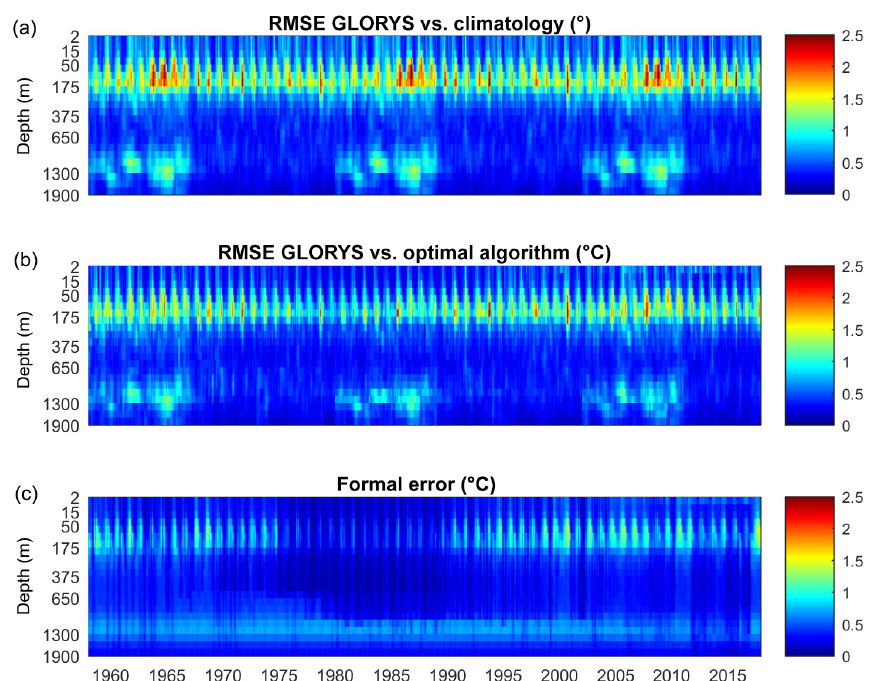
√ ˜ σ 2 ) of the background errors (in ◦ C). (b) Root-mean-square error (RMSE, in ◦ C) of the analysis fields Figure 7. (a) Standard deviation ( (cid:112) ˆ U 2 , in ◦ C). Note the vertical axis is distorted to enhance the visualization obtained using synthetic data from GLORYS. (c) Formal error ( of the upper layer.